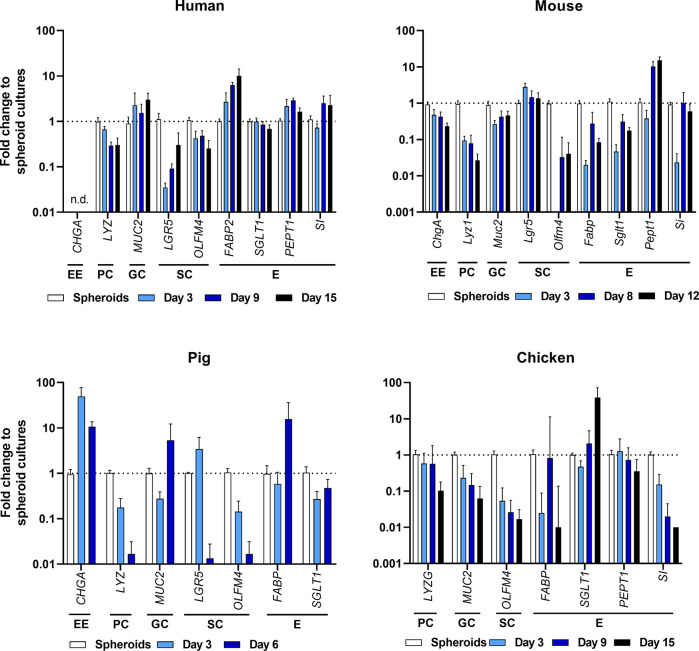
Expression profiling of intestinal cell types by RT-qPCR of ODMs from human, mouse, pig and chicken origin. Indicated markers represent EE, enteroendocrine cells; PC, Paneth cells; GC, goblet cells; SC, stem cells; and E, enterocytes. RT-qPCR experiments show mean (± 95% CI) of ≥ 4 technical replicas of at least two independent biological replicates. n.d., not detectable.